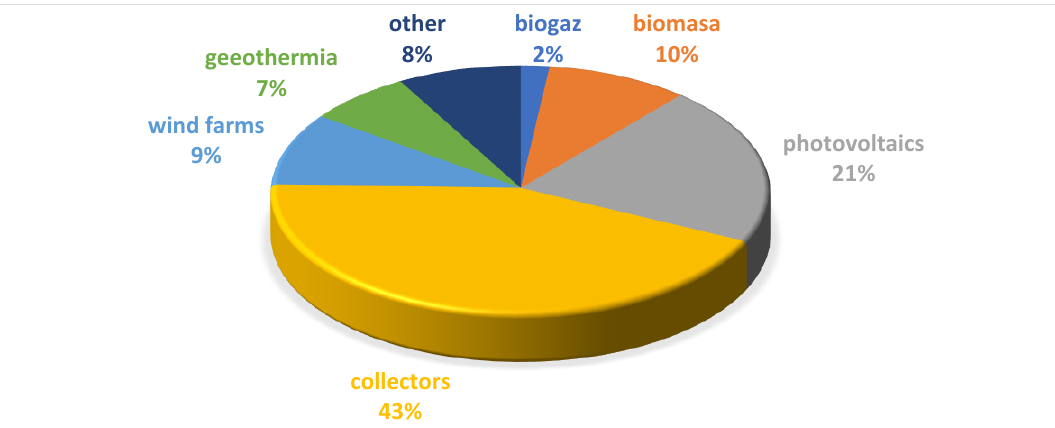
Figure 12. A type of renewable energy.